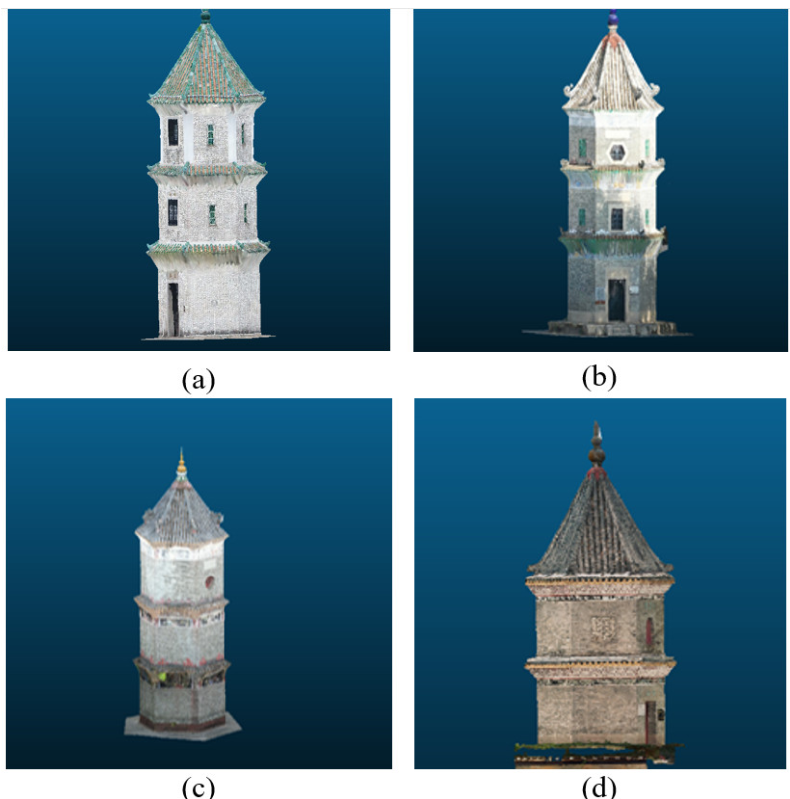
Figure 7. Pagoda point clouds: ( a ) Pagoda A; ( b ) Pagoda B; ( c ) Pagoda C; and ( d ) Pagoda